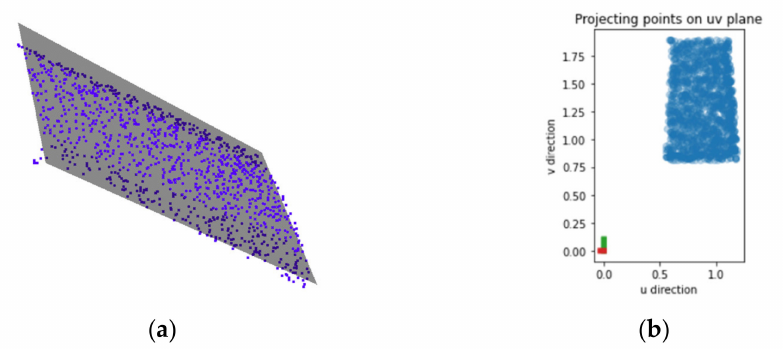
Figure 6. ( a ) Fitting plane to the point clouds; ( b ) projecting points to the projecting plane (u, v